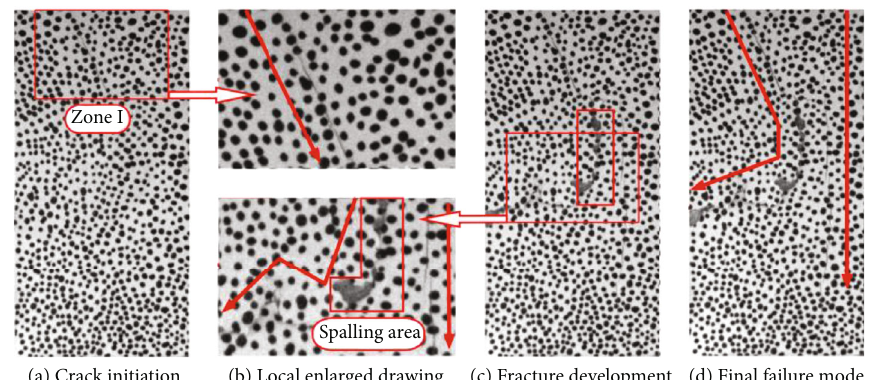
Figure 5: The surface fracture evolution process of specimen S1-2.